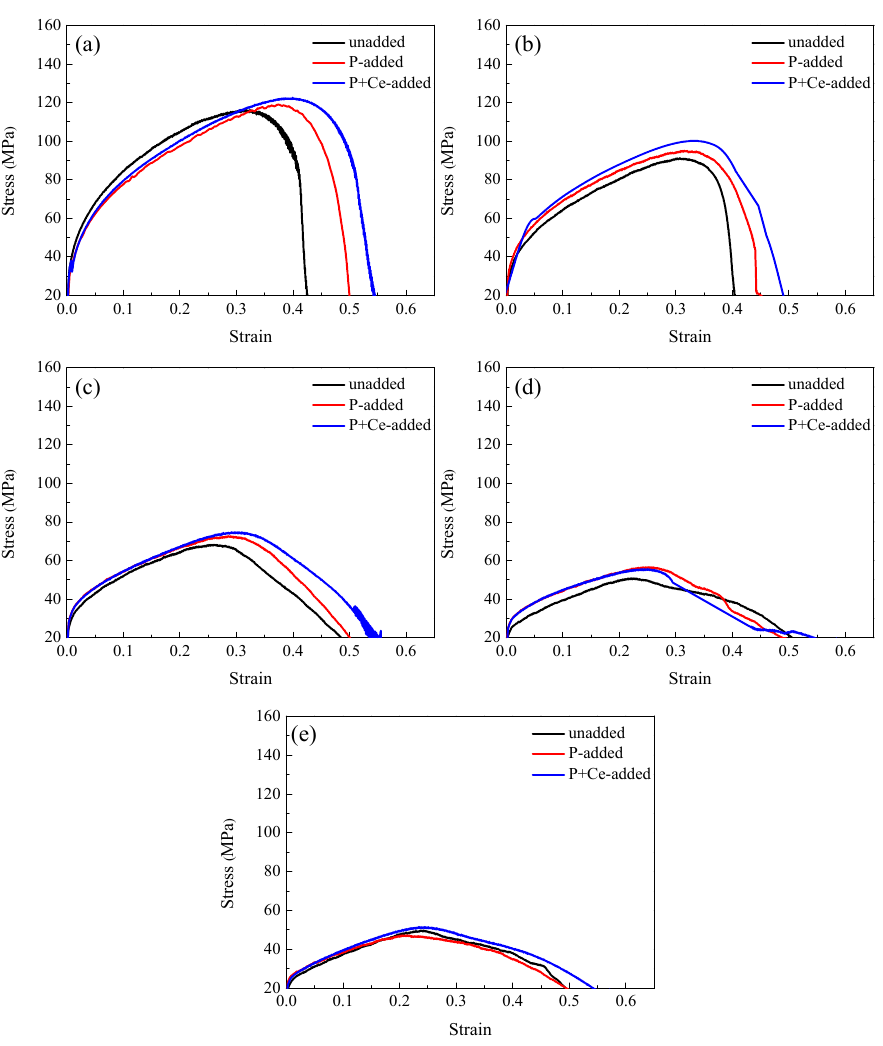
Figure 6. Stress–strain curves for the unadded, P ‐ added, and P+Ce ‐ added steels at different temperatures: ( a ) 800 °C, ( b ) 850 °C, ( c ) 900 °C, ( d ) 950 °C, and ( e ) 1000 °C.